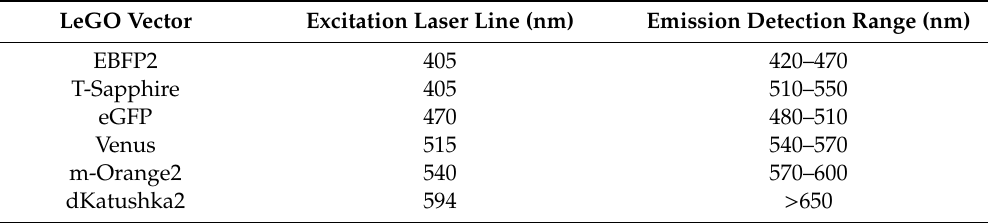
Table 3. Configuration of Leica TCS AOBS-SP8 X confocal